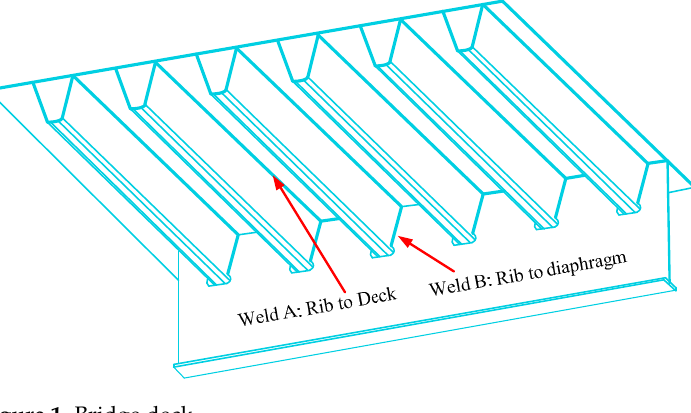
Figure 1. Bridge deck. Table 1. Probability distribution of random variables in three numerical case studies.